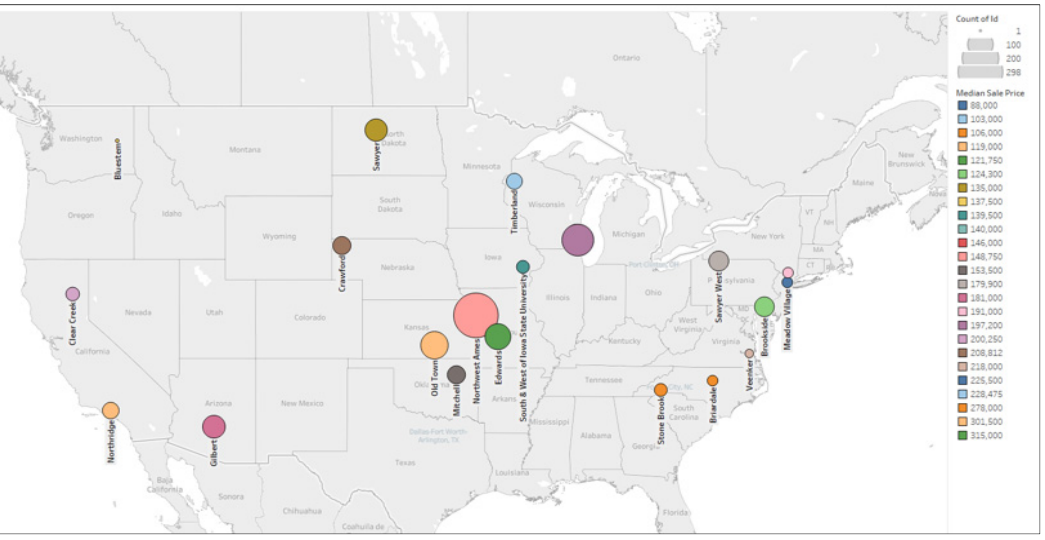
Figure 8. Map based on location: color shows details about median sale price of the house; size shows number of houses recorded in the labeled neighborhood.